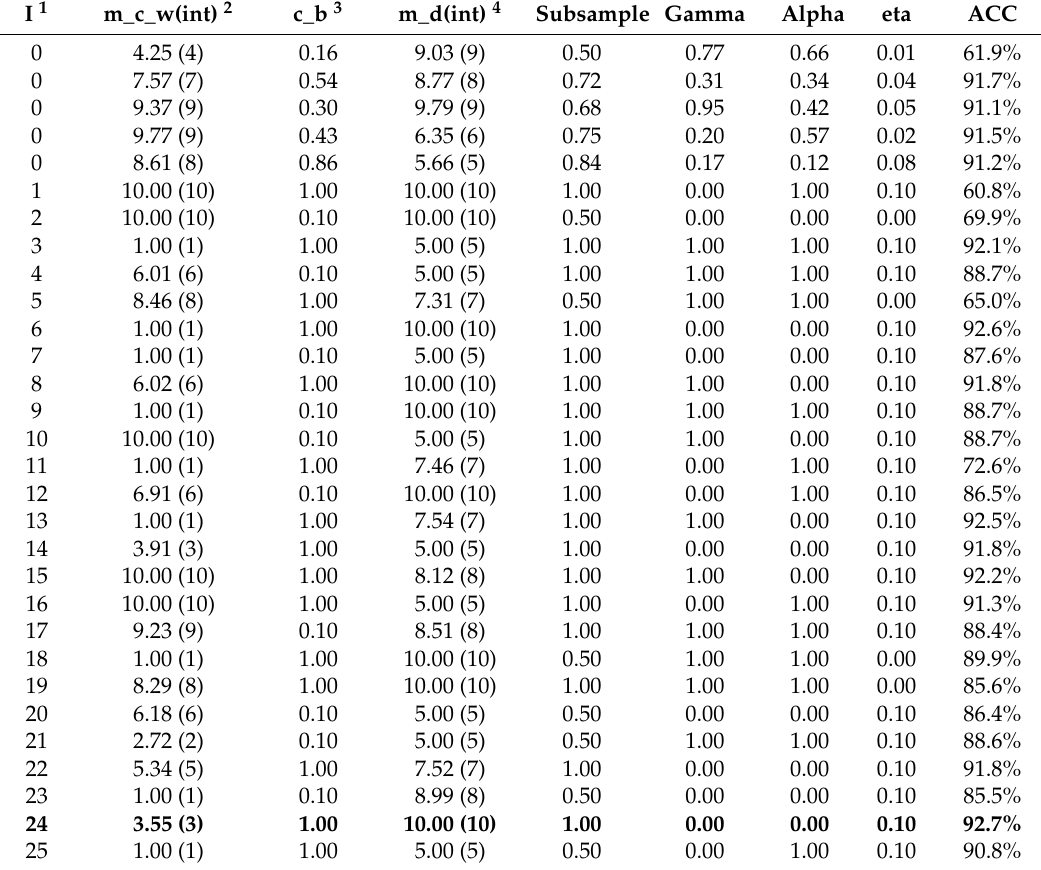
Table 15. Parameter Tuning Process of XGBoost Classifier.